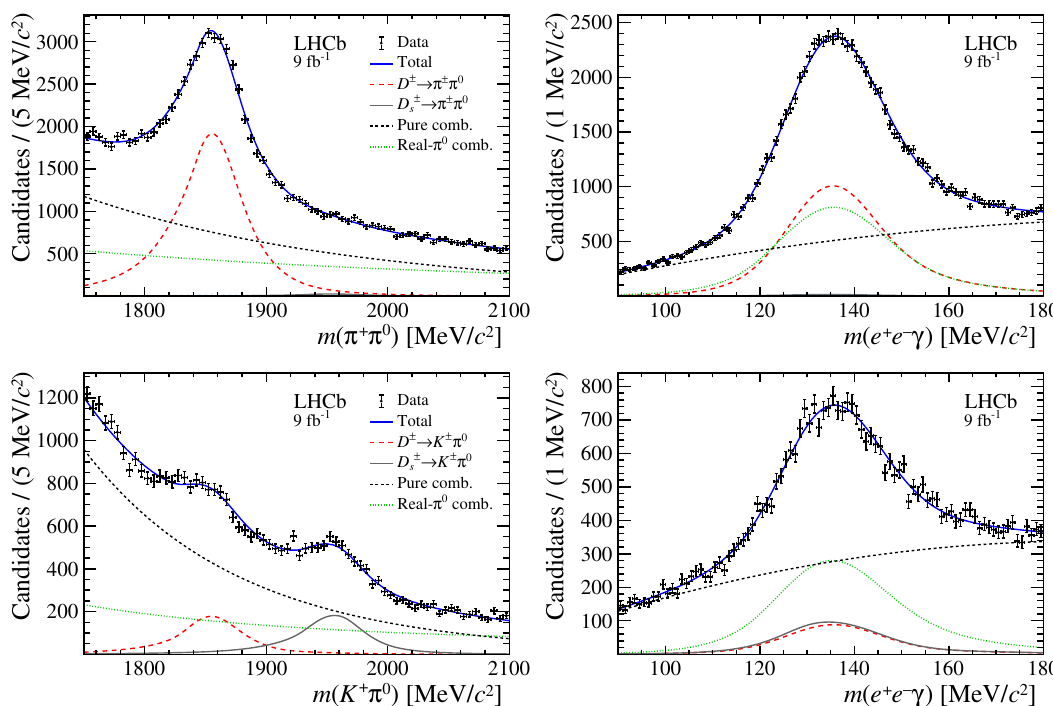
Figure 2. Distribution of the (left) m ( h + π 0 ) and (right) m ( e + e − γ ) mass for (top) D + (bottom) D + → K + π 0 candidates, summed over all categories of the simultaneous fit. Projections ( s ) of the total fit result and individual fit components are overlaid. This includes D + → h + π 0 decays in dashed red, D + → h + π 0 decays in solid grey, pure combinatorial decays in dashed black and s real- π 0 combinatorial background in dotted green. The misidentification background is too small to be seen in these